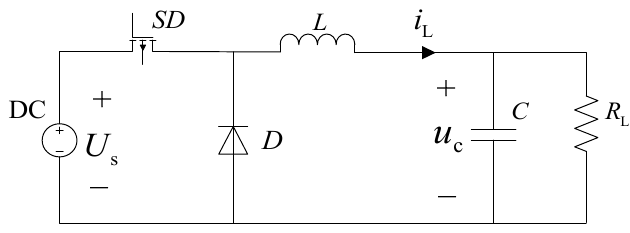
Figure 1. Circuit diagram of the Buck converter.